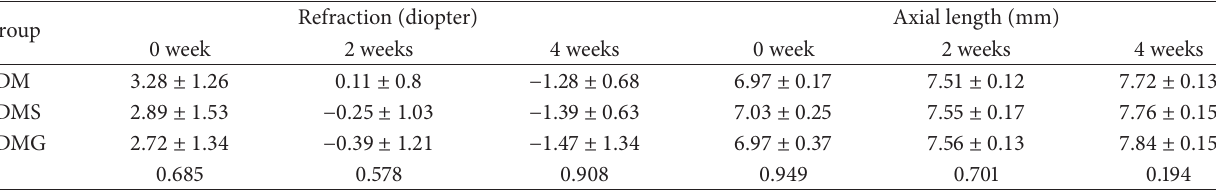
Table 2: The comparison of refraction and axial length of the right eyes among FDM, FDMS, and FDMG group at all time point (one-way ANOVA with Bonferroni